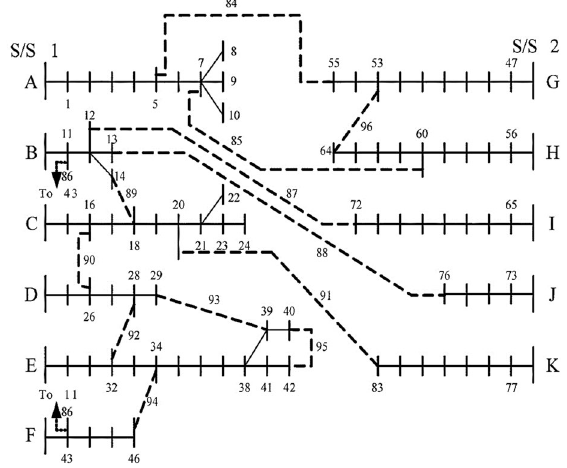
Fig. 5 Daily load profile